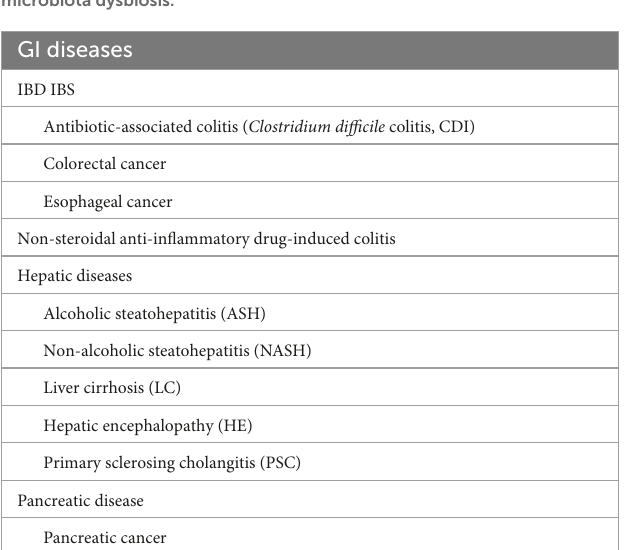
TABLE 2 GI system diseases reported to be associated with intestinal microbiota